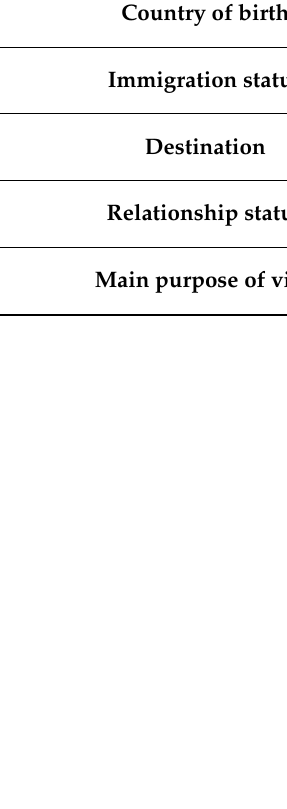
Table 4. Regression analysis summary of the host’s variables predicting the group size of travel